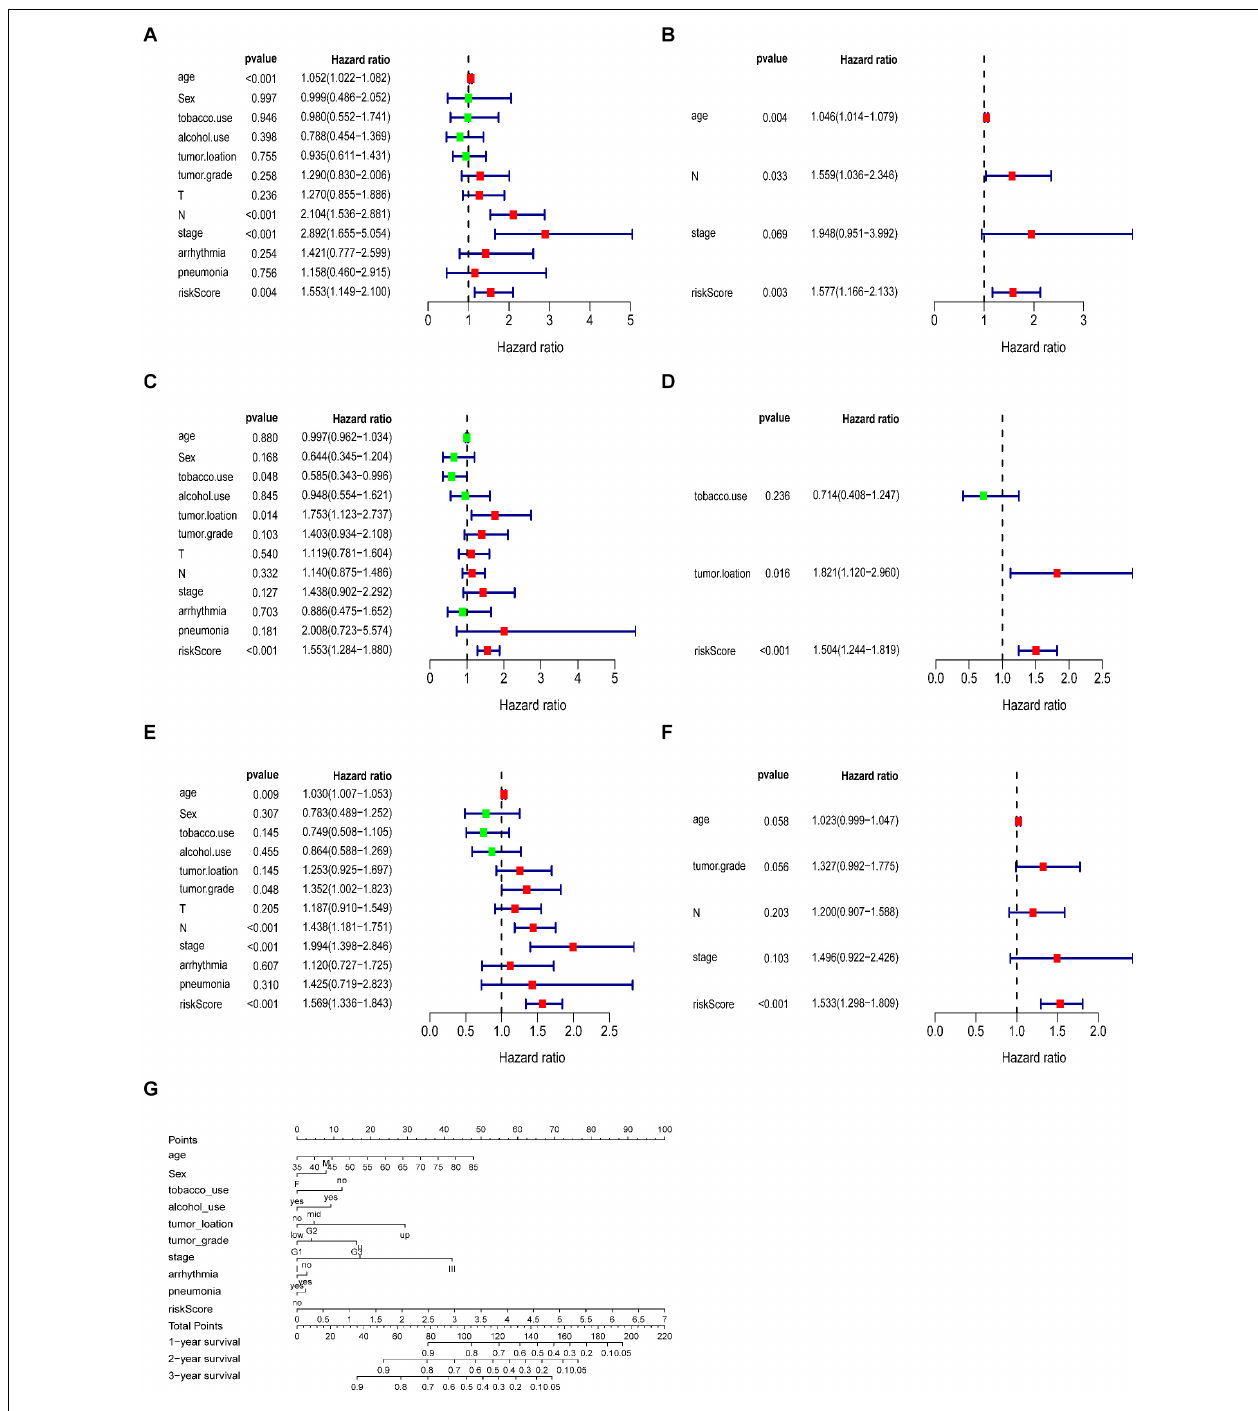
FIGURE 6 | Correlation between the prognostic signature and clinical characteristics of patients with ESCC. Univariate and multivariate Cox regression analyses of correlations between the ECM-related signature and clinical characteristics and overall survival in the training (A,B) , testing (C,D) and entire cohorts (E,F) . (G) Nomogram for predicting 1-, 3-, and 5-years overall survival in patients with ESCC.